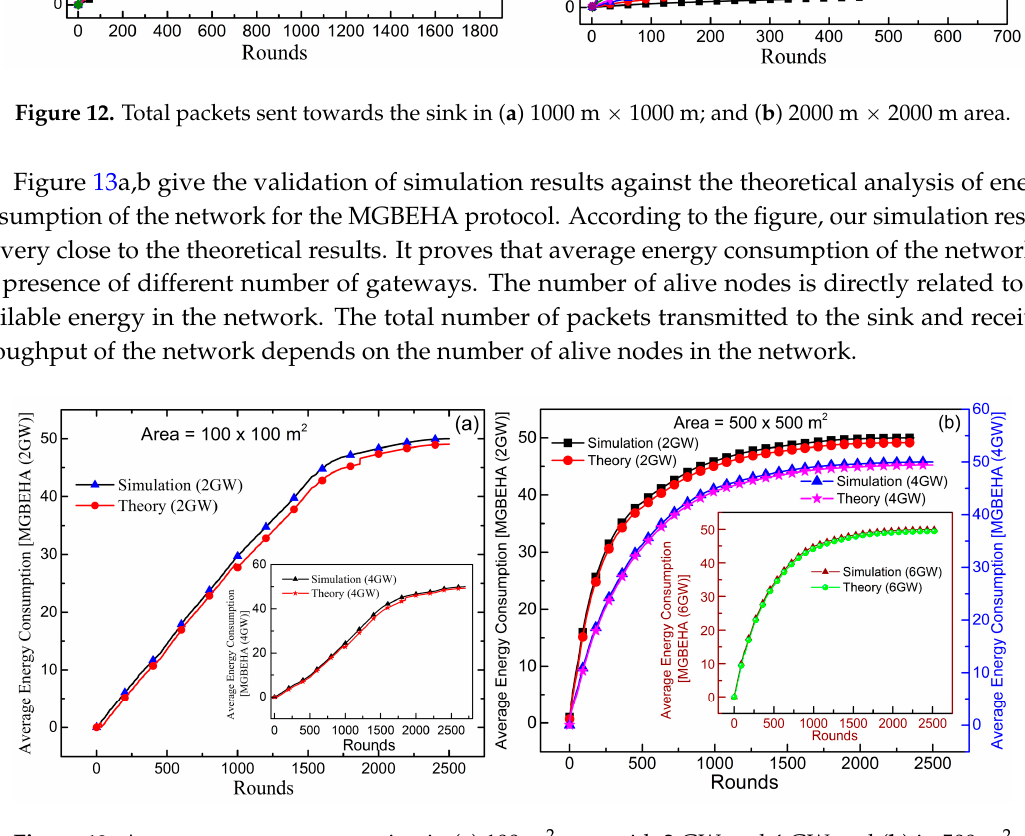
Figure 13. Average energy consumption in ( a ) 100 m 2 area with 2 GW and 4 GW and ( b ) in 500 m 2 with 2 GW, 4 GW, and 6 GW. with 2 GW, 4 GW, and 6